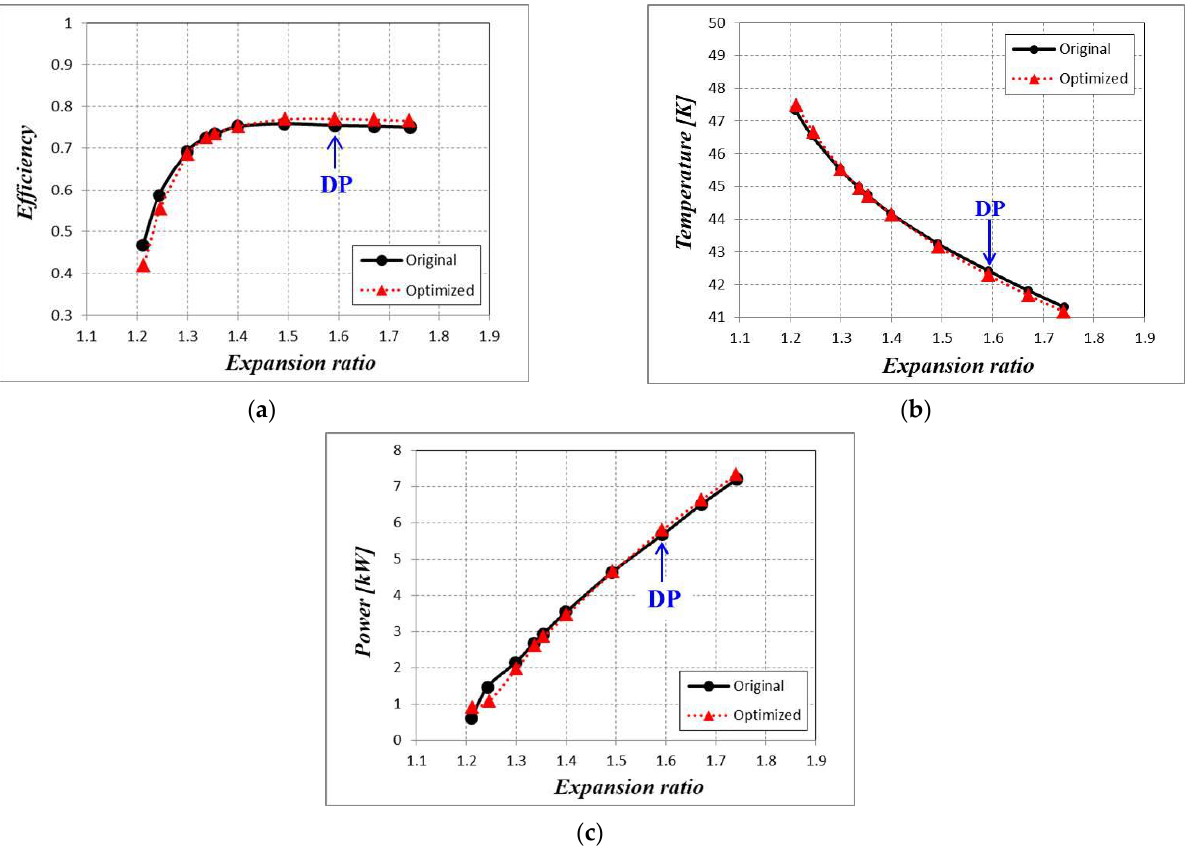
Figure 19. Performance comparisons between the original model and optimized model: ( a ) expansion ratio vs. efficiency; ( b ) expansion ratio vs. expander outlet temperature; ( c ) expansion ratio vs. expander power. Table 6. Efficiency and outlet temperature comparisons between original and optimized models.